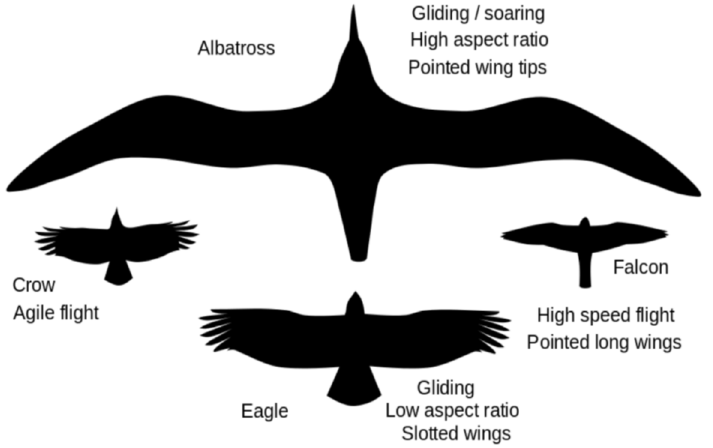
Figure 12. Classification of wing shape: elliptical wings, high-speed wings, high-aspect ratio wings, and slotted high-lift wing [32].